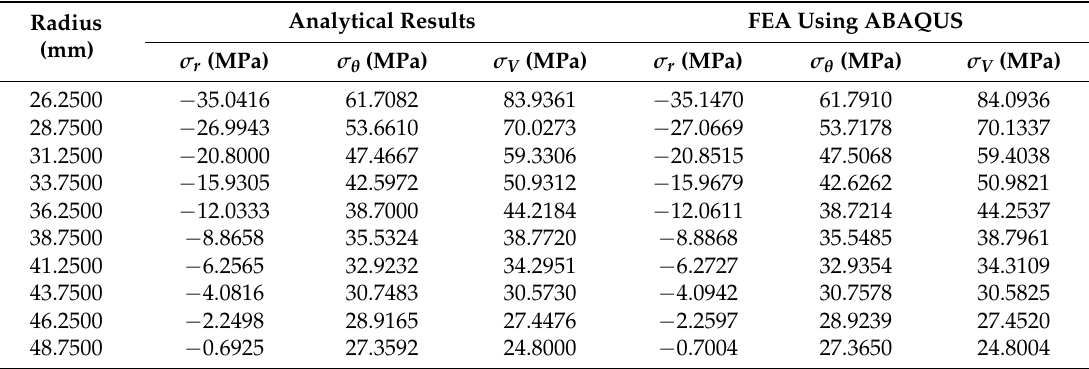
Table 2. Comparison of analytical and finite element analysis (FEA) using ABAQUS results by using von Mises stress.